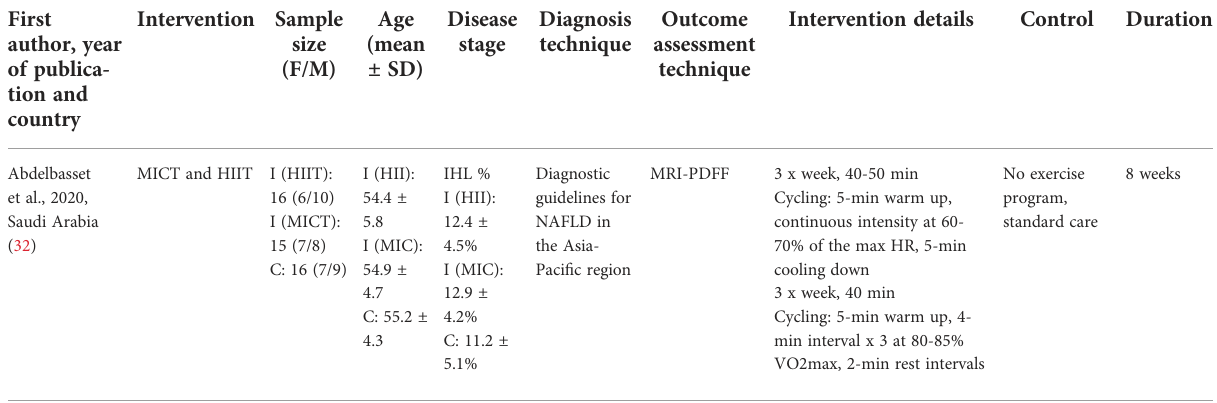
TABLE 1 The characteristics of the included randomized controlled trials